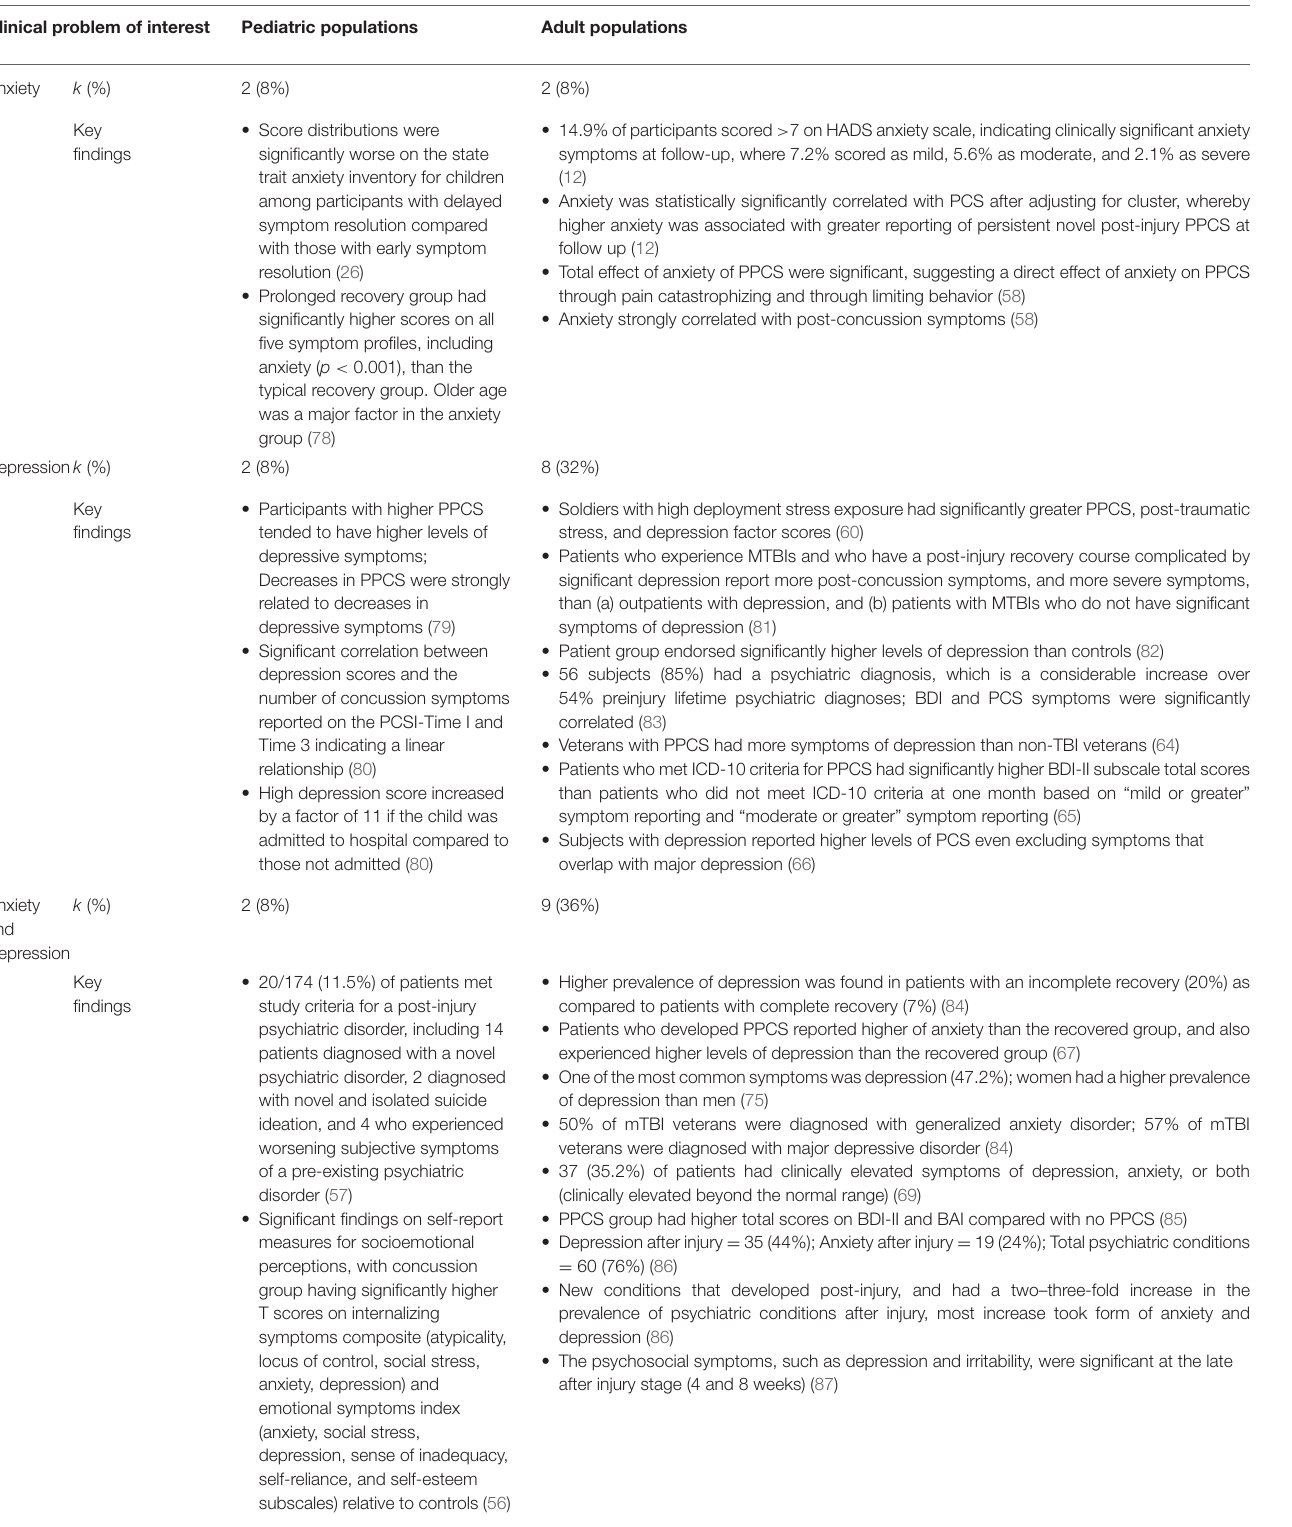
TABLE 2 | Key findings across the lifespan. Clinical problem of